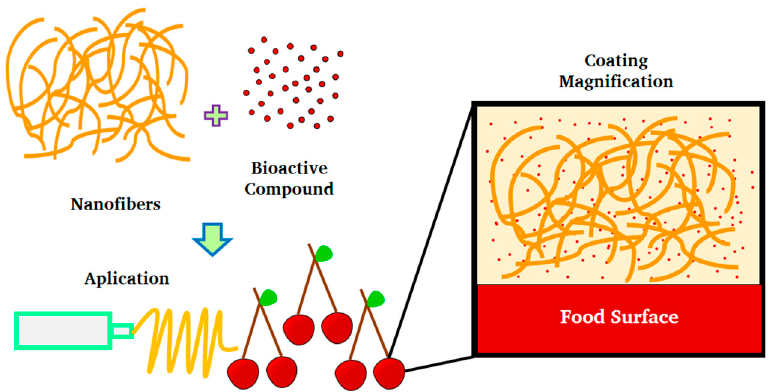
Figure 5. Nanofibers in edible coatings.